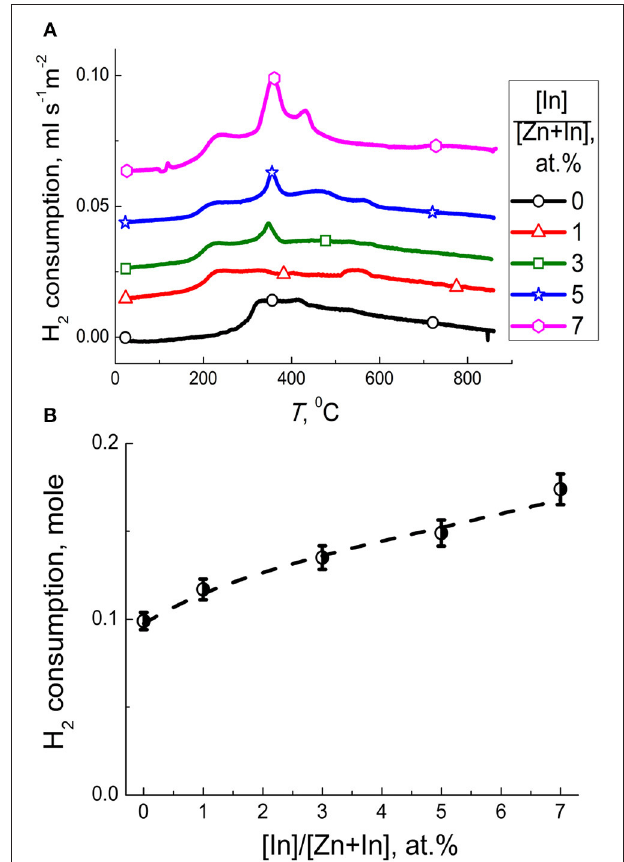
FIGURE 7 | (A) Temperature profiles of H 2 consumption by zinc oxide modified by different amounts of In 2 O 3 . (B) Amount of hydrogen consumed per one mole of ZnO/In 2 O 3 with different indium oxide content at temperature 150–600 ◦ C excluding the hydrogen uptake by the In 2 O 3